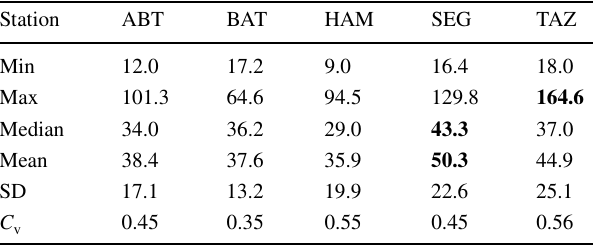
Table 3 The characteristics of the annual maximum precipitation in the analyzed period